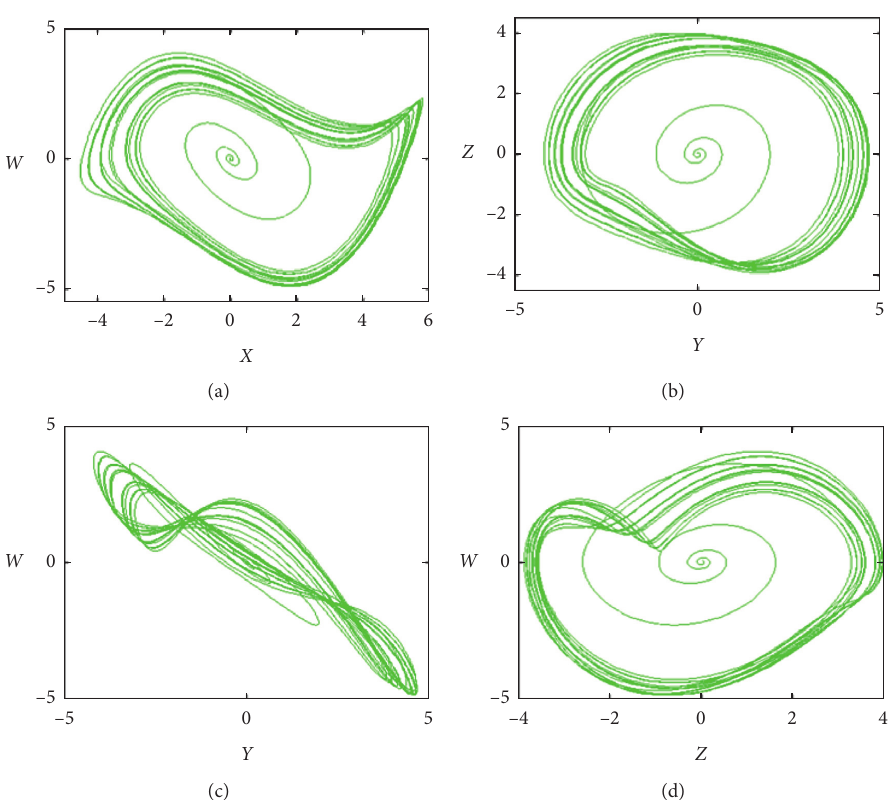
Figure 17: Strange attractor projections on various planes of system (1) with (a) � 0.8, (b) � 0.5, (c) � 1, (d) � 0.1under the initial condition (0.01, 0.01, 0, 0).